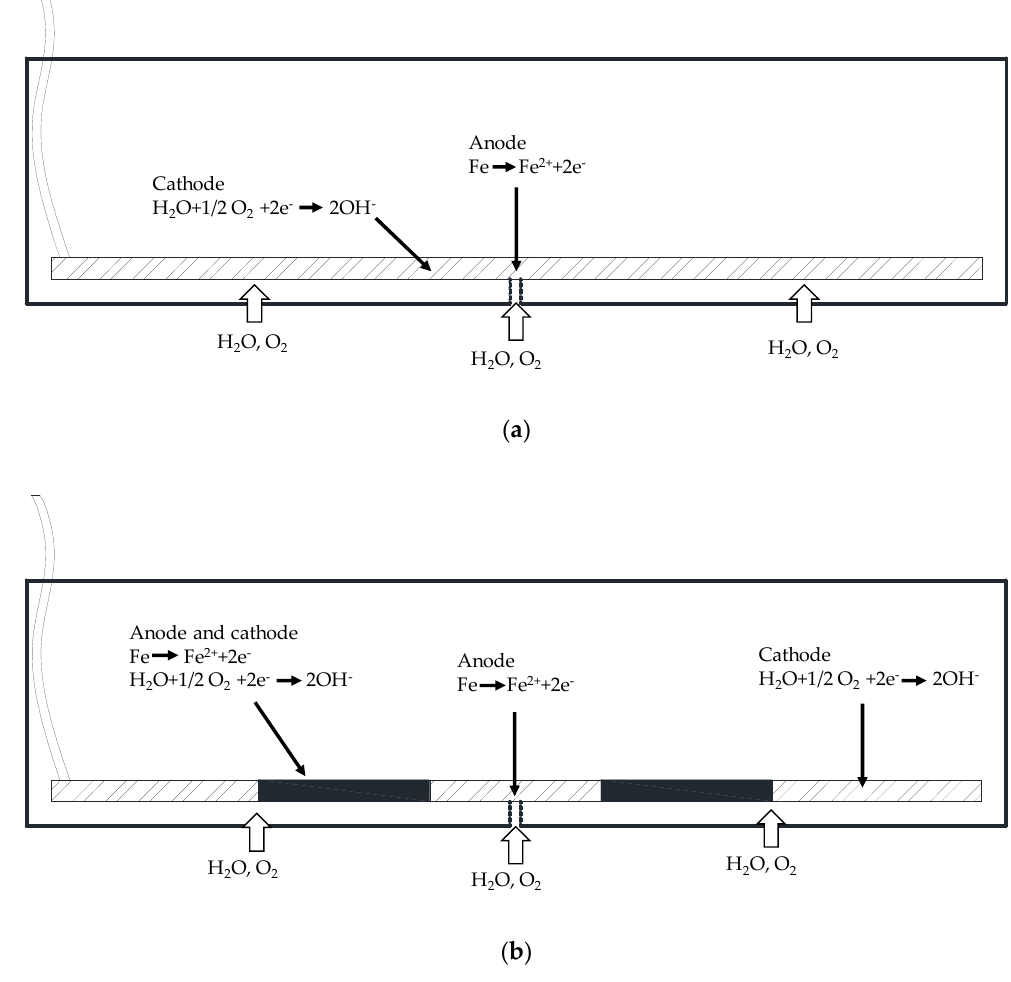
Figure 12. Corrosion mechanism of steel in conventional concrete: ( a ) crack, ( b ) crack and SCID.